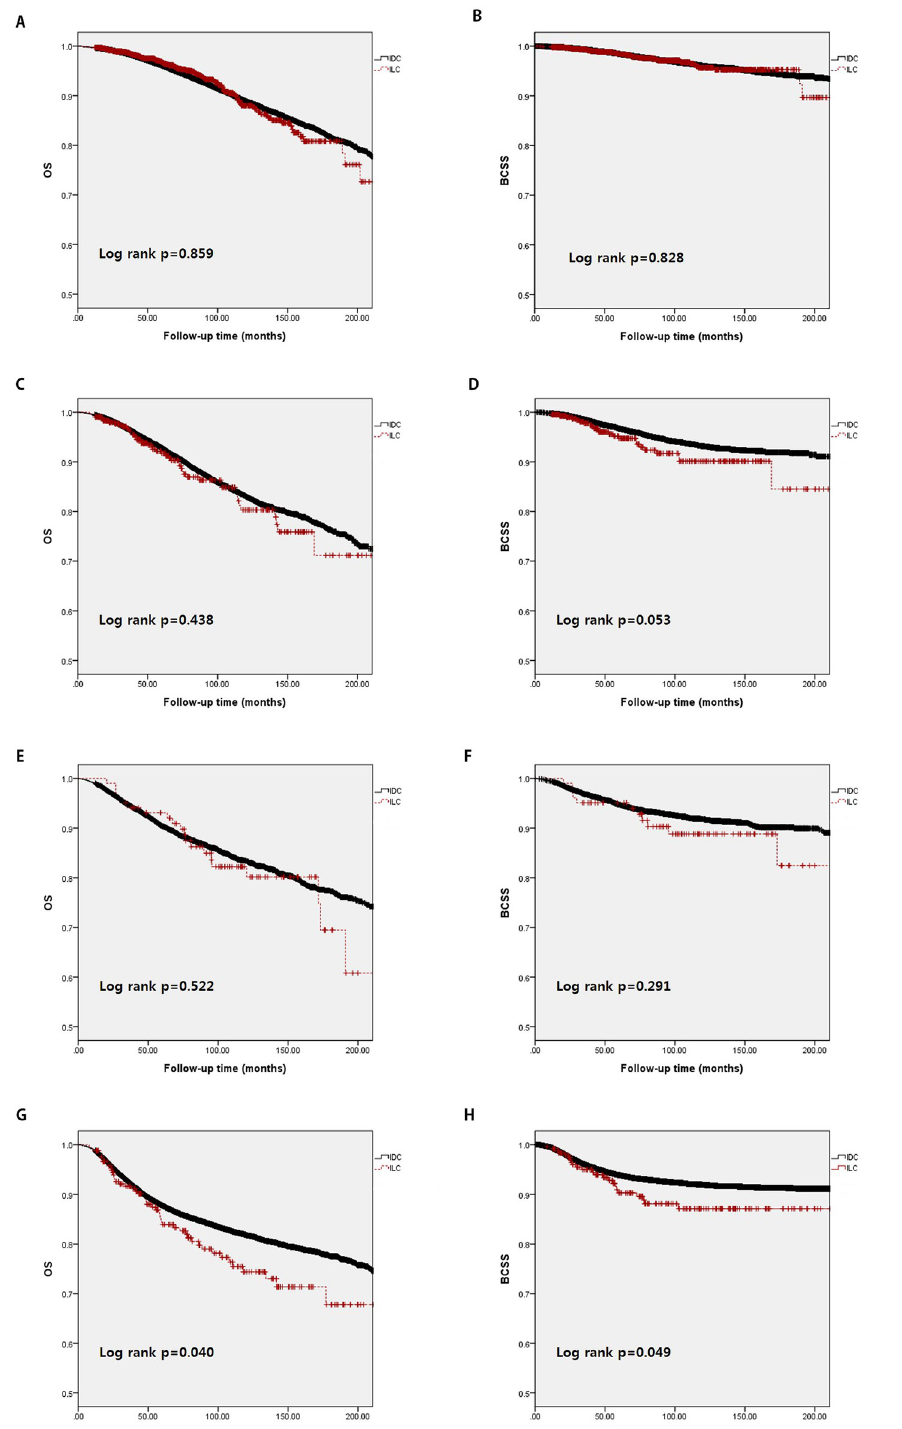
Fig 5. Kaplan–Meier survival analysis of overall survival (OS) (A, C, E, G) and breast cancer-specific survival (BCSS) (B, D, F, H), in the ER positive/PR positive (A, B), ER positive/PR negative (C, D), ER negative/PR positive (E, F), and ER negative/PR negative subgroups (G,